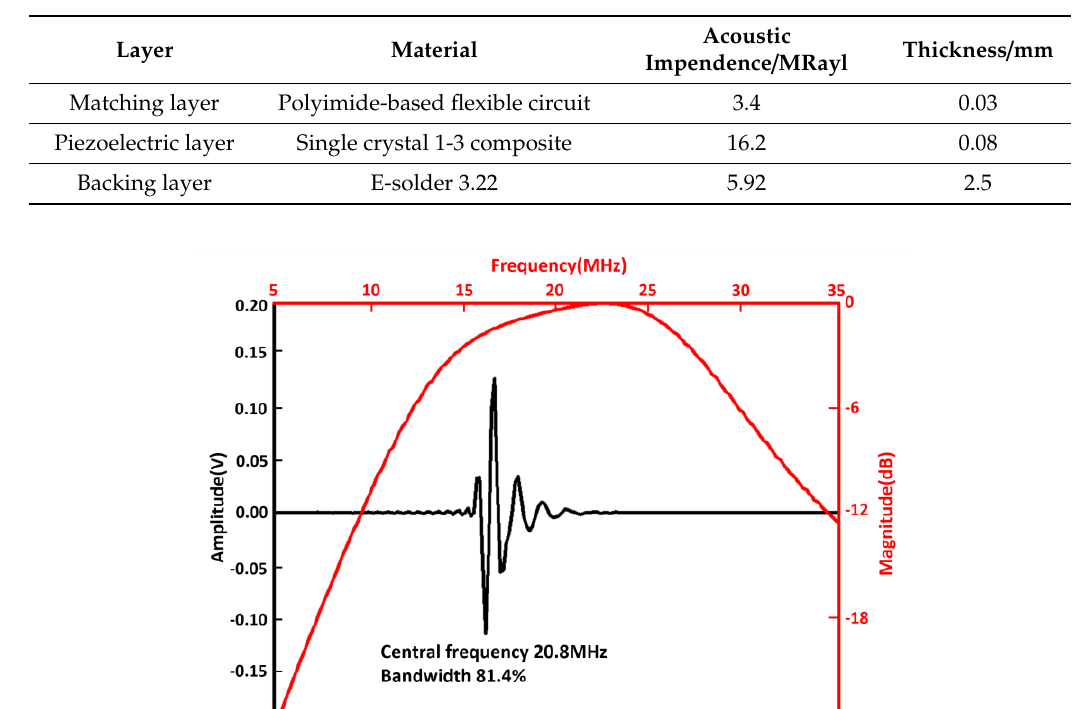
Table 2. The acoustic design parameters for piezoelectric single crystal 1-3 composite phased